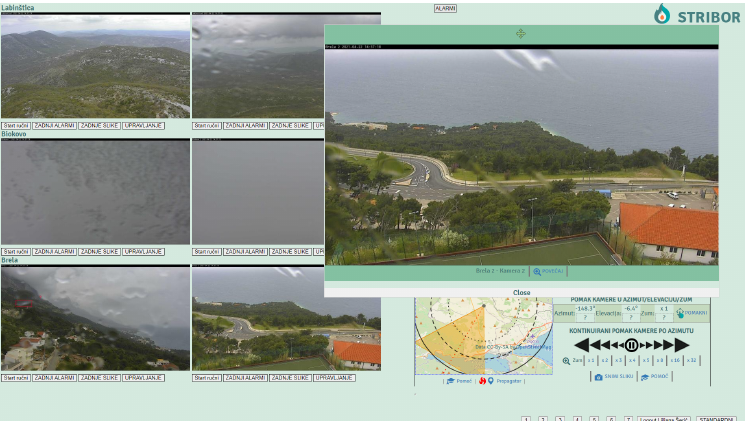
Figure 7. Forest fire surveillance interface displaying all relevant information about the fire event.